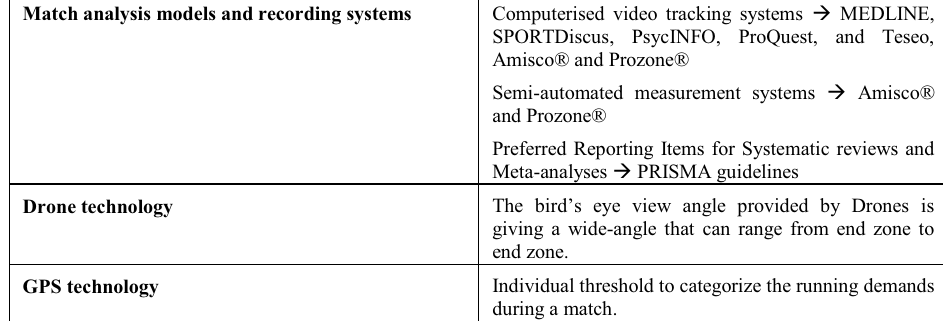
Table 1 - Technological tools to analyse the physical performance of the elite players. Match analysis models and recording